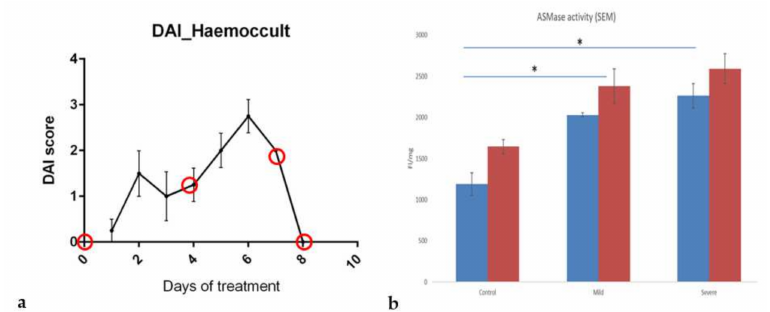
Figure 2. The inflammation status and progression of the disease were tracked with the disease activity index (DAI) score in DSS-treated mice ( a ). The DAI combines weight loss scores to initial body weight, stool consistency (fecal score), and hemoccult (fecal bleeding). The scoring system can be employed for the comparative analysis of intestinal bleeding [28]. The red circles present the chosen endpoints where animal colons were collected ( n = 4 in each endpoint) and analyzed. Acid sphingomyelinase (aSMase) activity was measured from the mouse proximal (blue column) and distal (red column) colon homogenates using Amplex red aSMase assay kit ( b ). The tissue samples were collected from healthy, mildly inflamed (three day DSS treated) and severely inflamed (five day DSS treated) animals ( n = 4 in each group). The samples were weighed and homogenized, and fluorescence was analyzed. The fluorescence intensity (FI) was standardized with the tissue weight (mg). The animals without DSS treatment were used as the control. All tissue sample activities were analyzed simultaneously, and data are presented as mean ± SEM. A t -test determined significance. * p <